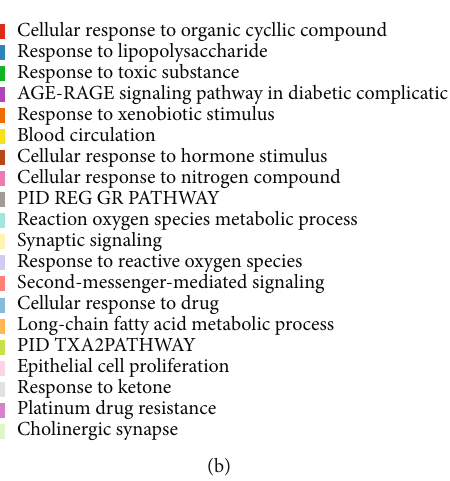
Figure 2: Graph of the GO function analysis bar and PPI. (a) GO analysis. (b) PPI